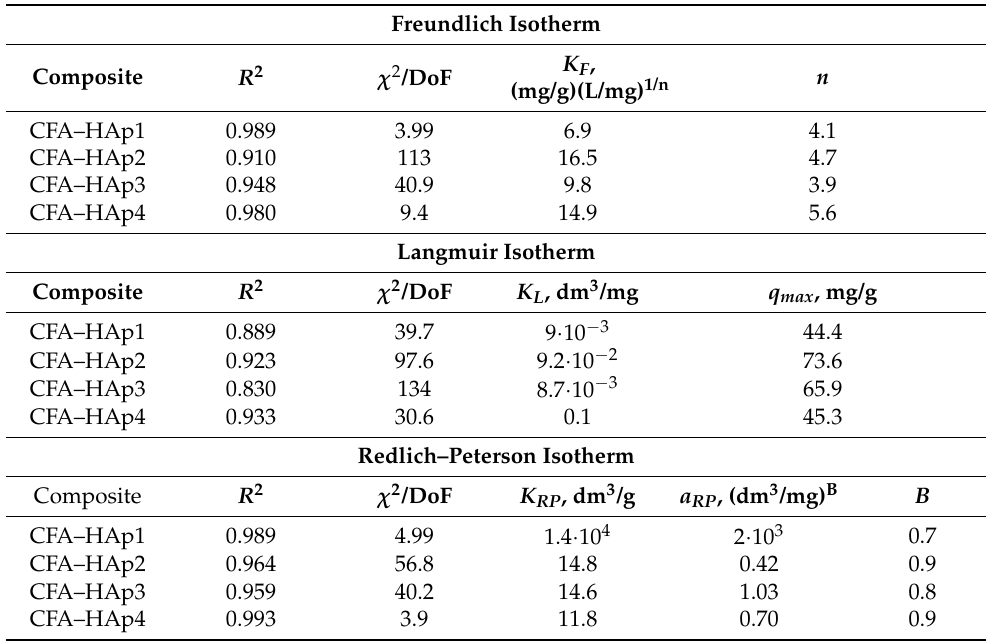
Table 4. Parameters of the isotherm models of Cu(II) adsorption on the CFA–HAp composites.